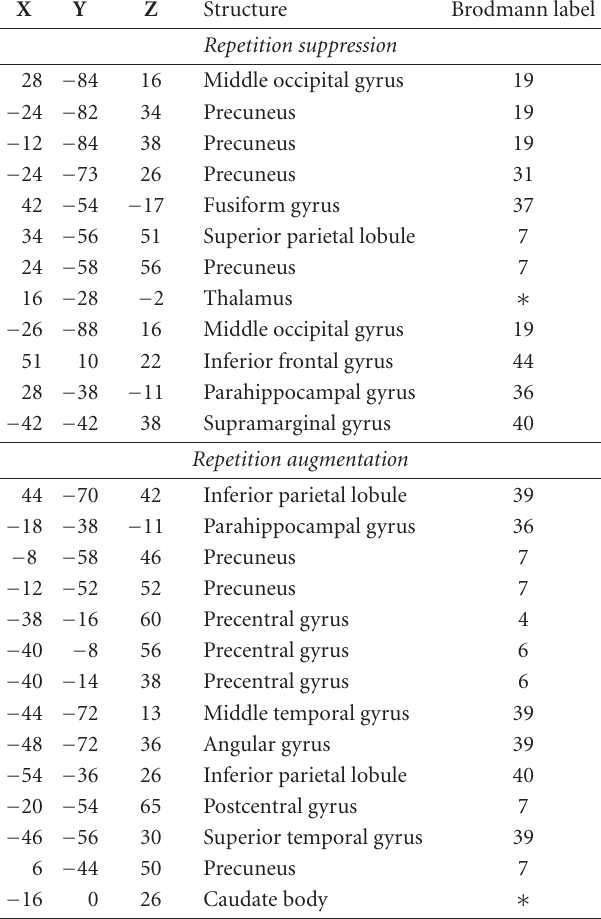
Table 1: Nearest gray-matter voxel locations assigned positive or negative weights ( | Z | > 3 . 09) in the bootstrapped OrT pattern, which represents the neural e ff ects of repeated presentations of “possible” objects. MNI coordinates, structure name, and Brod- mann label are tabulated for (a) brain regions in which sig- nal strength decreases with object repetition ( repetition sup- pression ); and (b) regions in which signal strength increases with object repetition ( repetition augmentation ). Localization with Talairach Demon available from http://ric.uthscsa.edu/projects/ talairachdaemon.html. X Y Z Structure Brodmann label Repetition